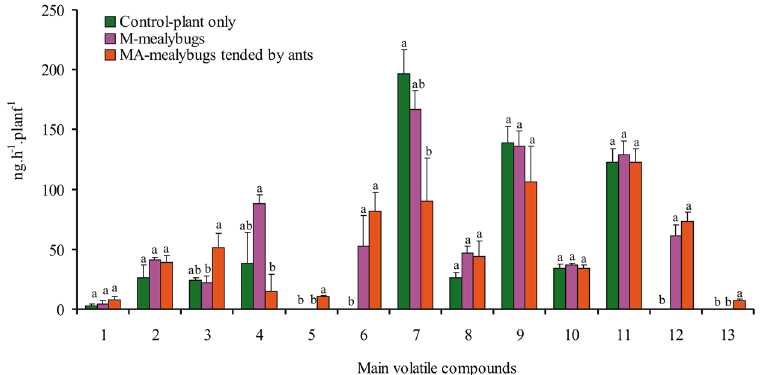
Figure 7. Means and standard error (ng.h − 1 .plant − 1 ) of main compounds emitted by cotton infested with mealybugs (M) or infested with mealybugs tended by ants (MA) or infested no mealybugs (Control). Code 1~13 on axis X indicate the main volatile compounds, there are octanal, nonanal, ρ -cymene, methyl nicotinate (4), MeSA (5), β -curcumene (6), dodecane, decanal, tetradecane, laurylacetate, hexadecane, cedrol (12), and one unidentified compound (13),